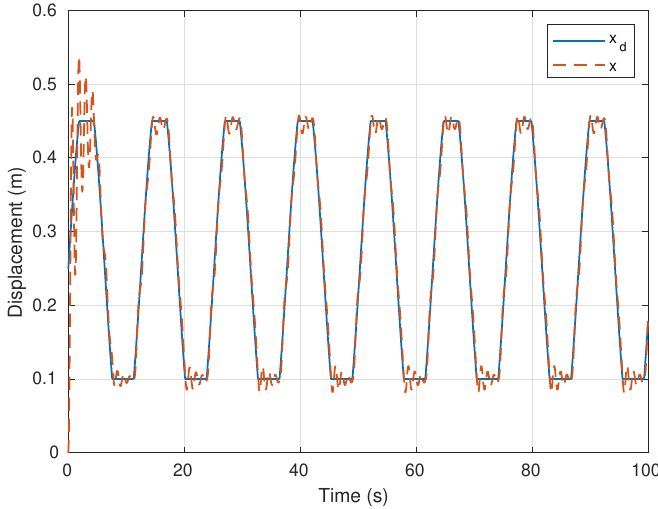
Figure 13. Point-to-point movement tracking performance. (2) PAMs in antagonistic pairs control